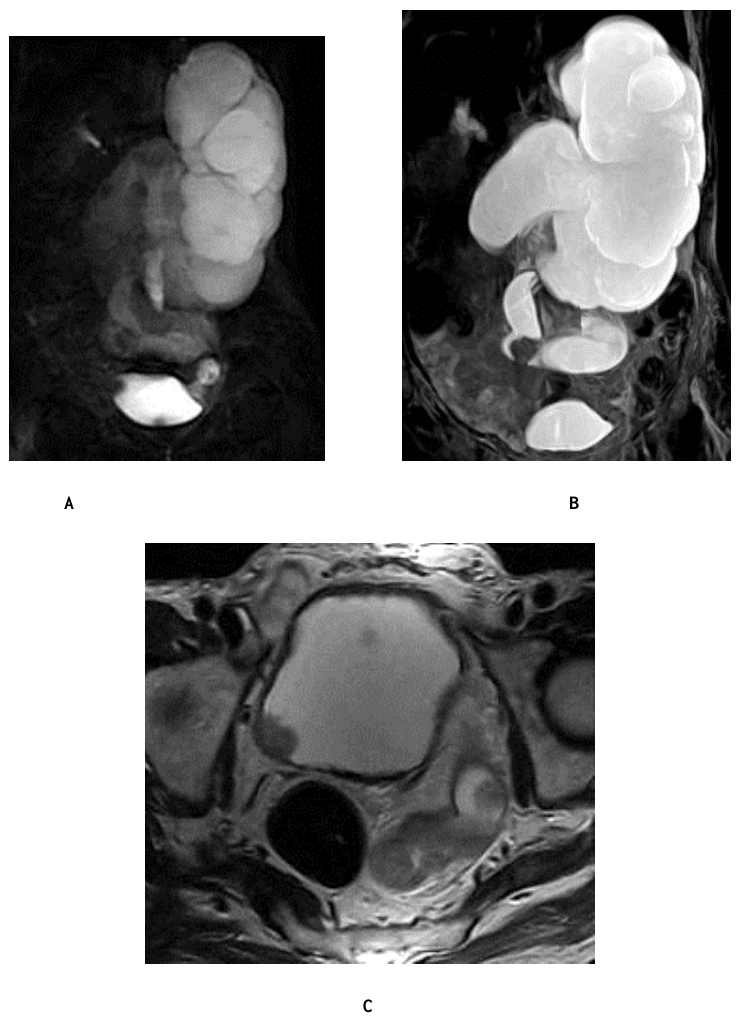
FIGURE 3. A case of multicentric intavesical and left ureteric transitional cell carcinoma. (A) Single-shot MRU shows ill- defined soft tissue lesions at urinary bladder. (B,C) Coronal reformatted MRU and axial T2w at the pelvis show the multicentric left ureteric and urinary bladder soft tissue masses.